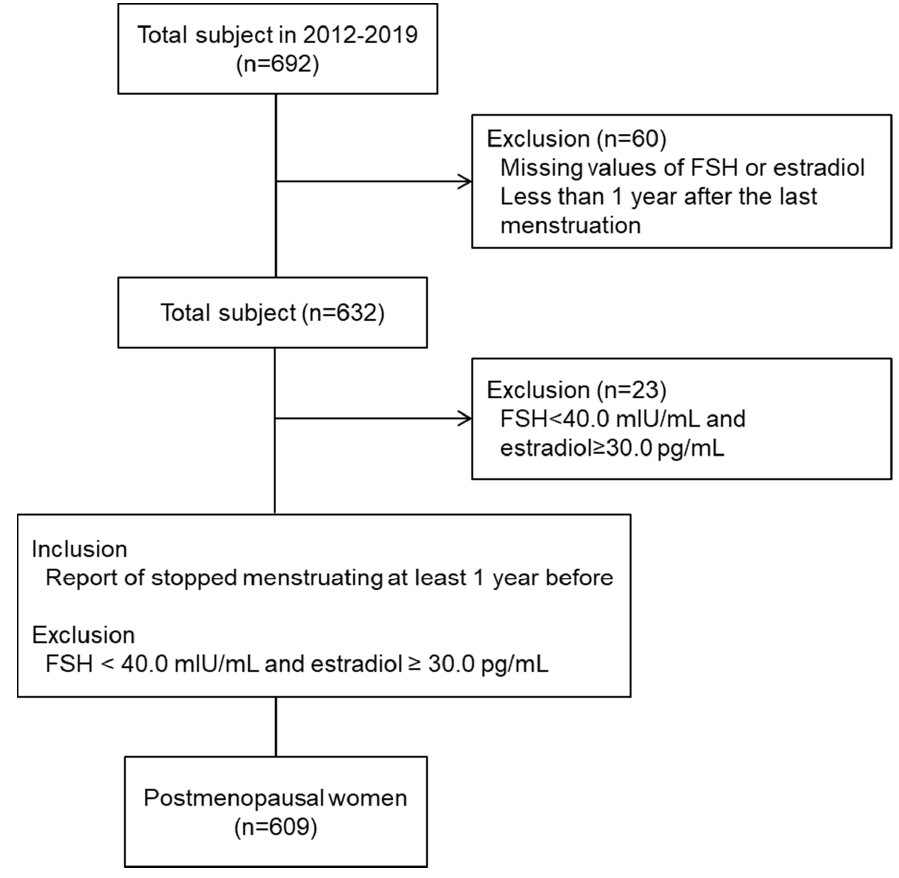
Figure 1. Flow diagram of study selection process.